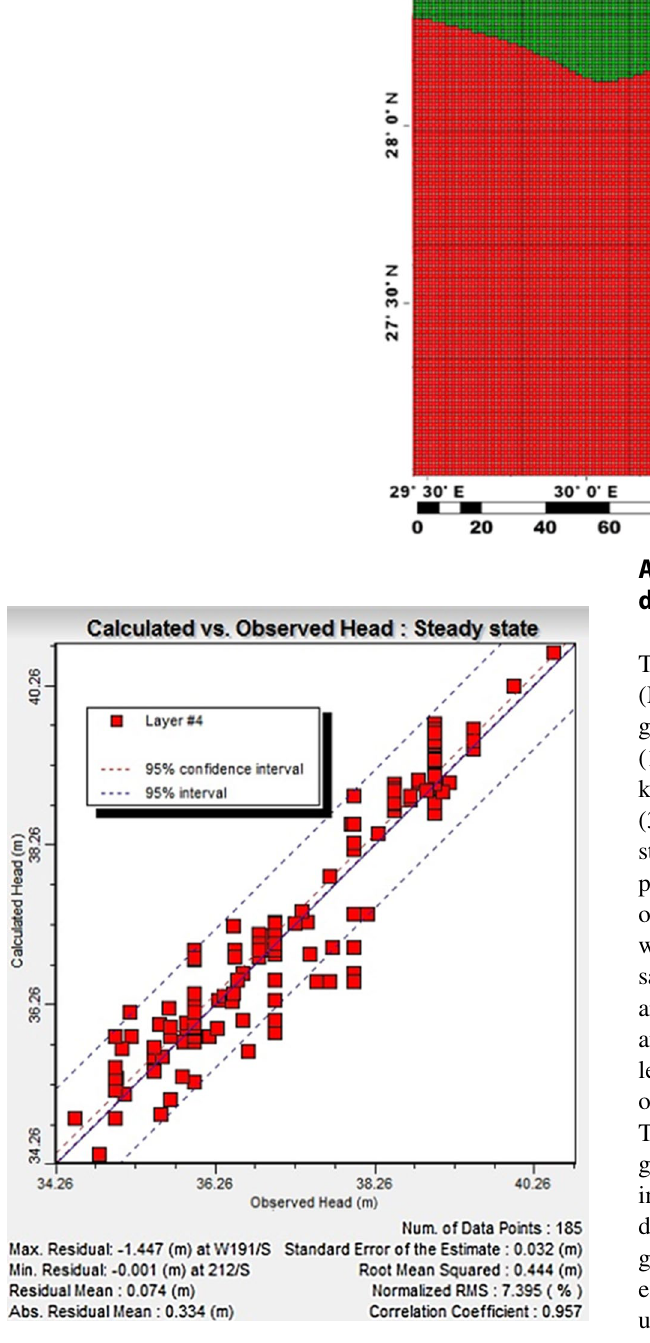
Fig. 14 Scatter plot of observed versus calculated heads in the steady- state